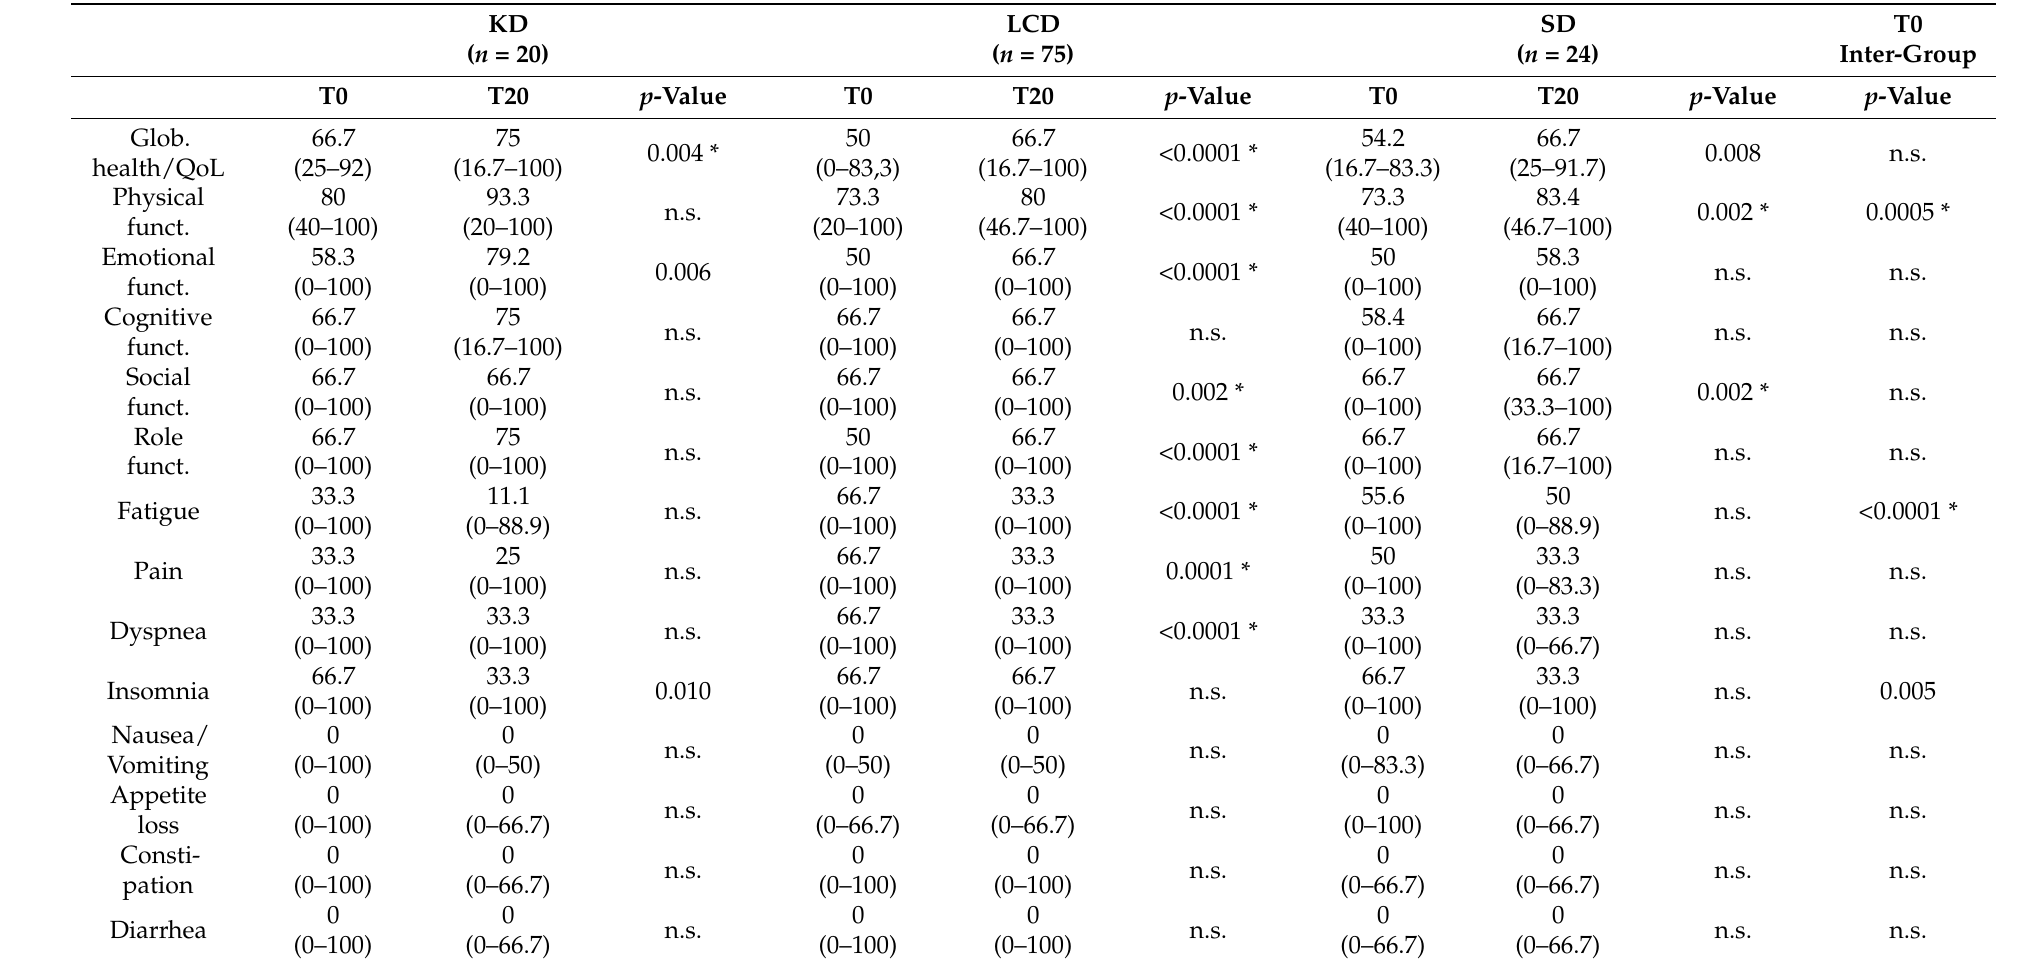
Table 4. Quality of life (EORTC-QLQ C30, version